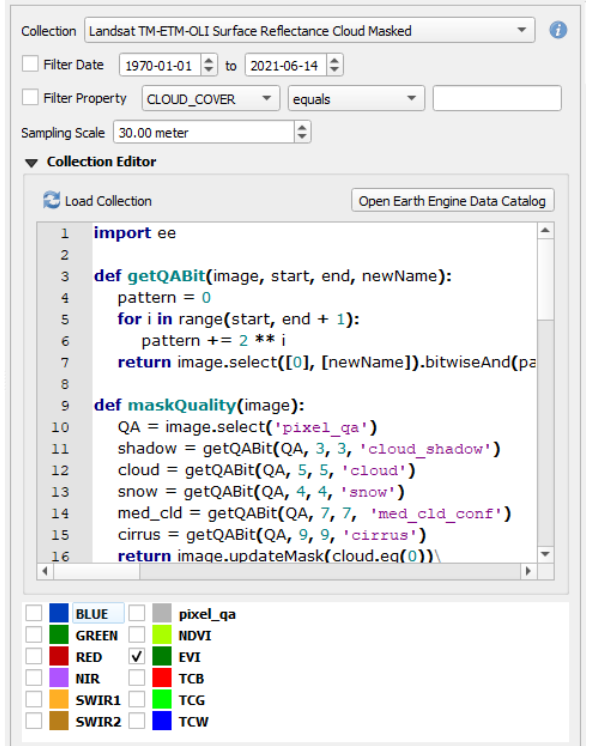
Figure 1 . Collection settings and Python collection editor to define or modify image collections, here the predefined cloud- masked Landsat TM, ETM+, and OLI surface reflectance collection. Figure 3 . Sentinel-2 NDVI time series and visualization settings (top), and image visualization (bottom, R/G/B: near infrared / red / green, acquisition date